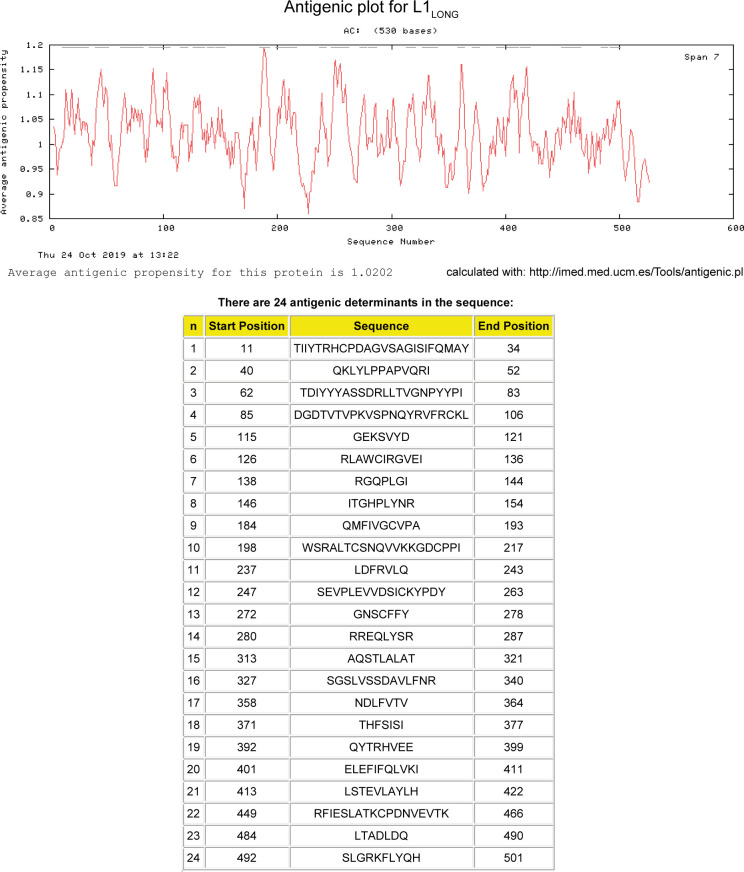
Immunogenicity prediction of L1LONG.Prediction of antigenic determinants within L1LONG suggests an immunogenic epitope between residues 11 and 34 of the N-terminus of L1LONG. Also the DE loop (determinant no. 8) and partially the FG loop (last 2 residues of determinant no. 12) are predicted.